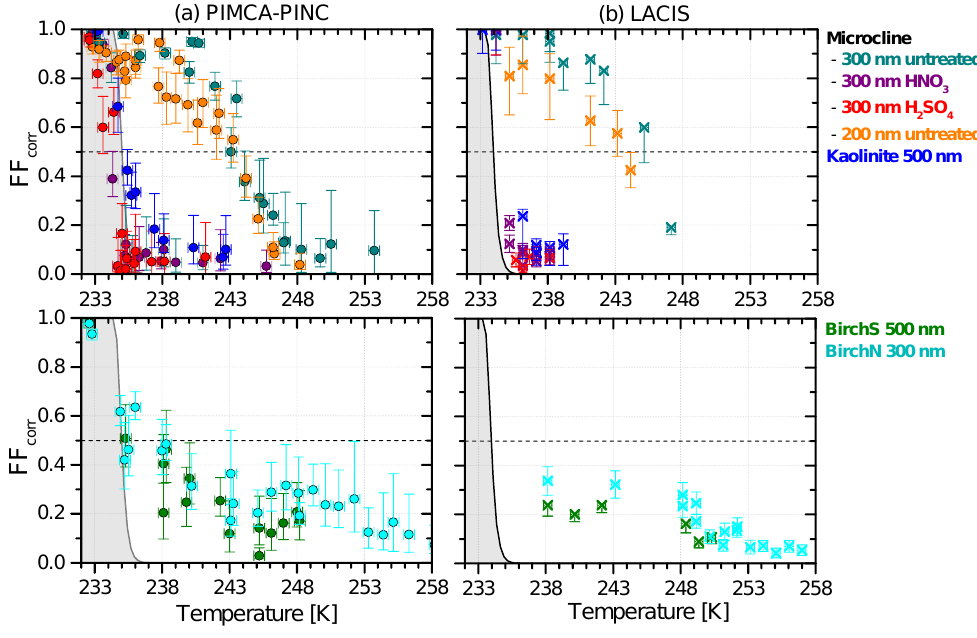
Figure B1. Frozen fraction for results obtained with PIMCA-PINC (a) and LACIS (b) accounting for the fraction of multiple-charged particles in the quasi-monodisperse sample given in Table